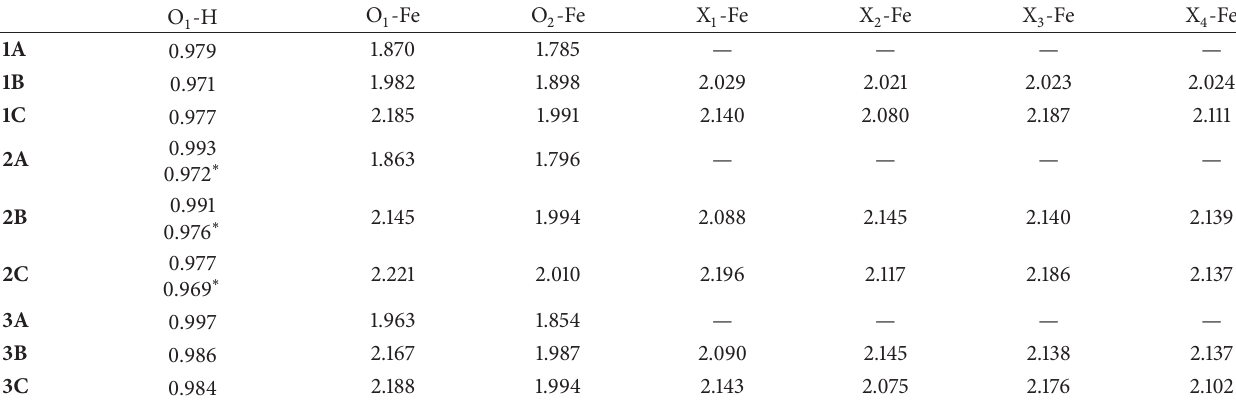
Table 3: Metal-ligand and O-H bond lengths ( > ) of the complexes obtained from B3LYP/6-31G(d)(Fe)U6-31+G(d,p)(E). O 1